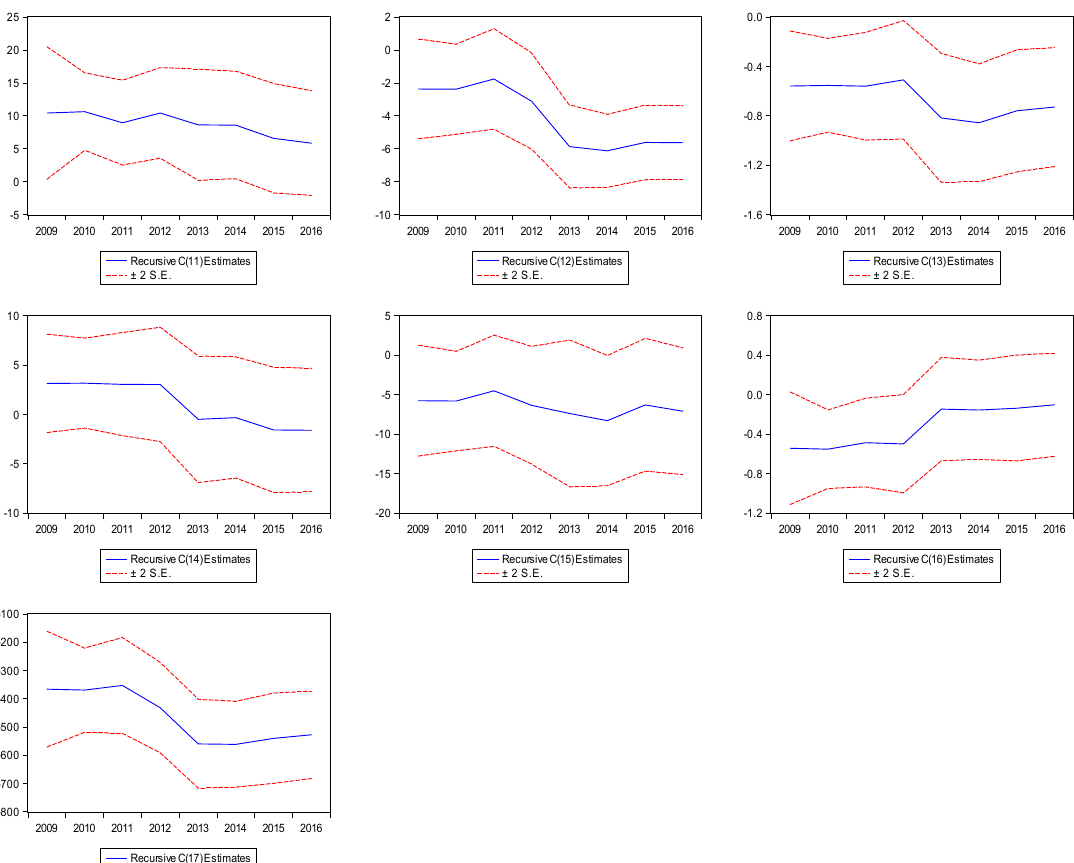
Figure 9. Recursive least squares graphs for the long-run model.